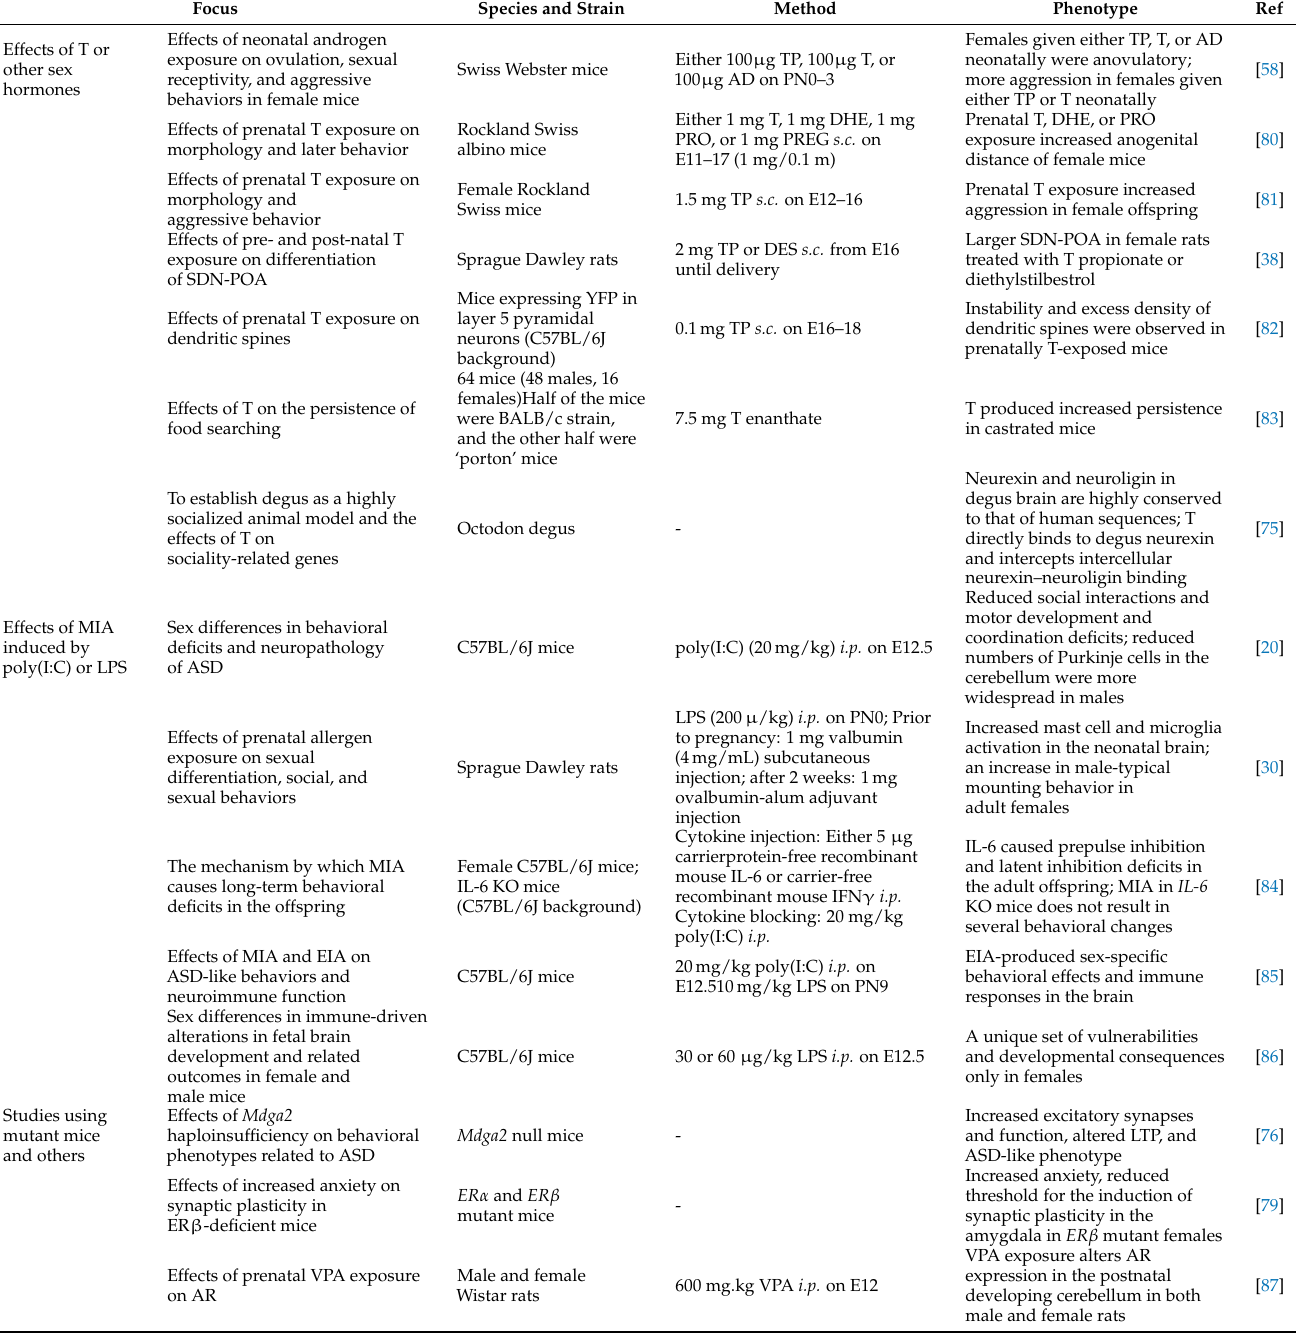
Table 2. Summary of animal studies on sex differences and ASD-like